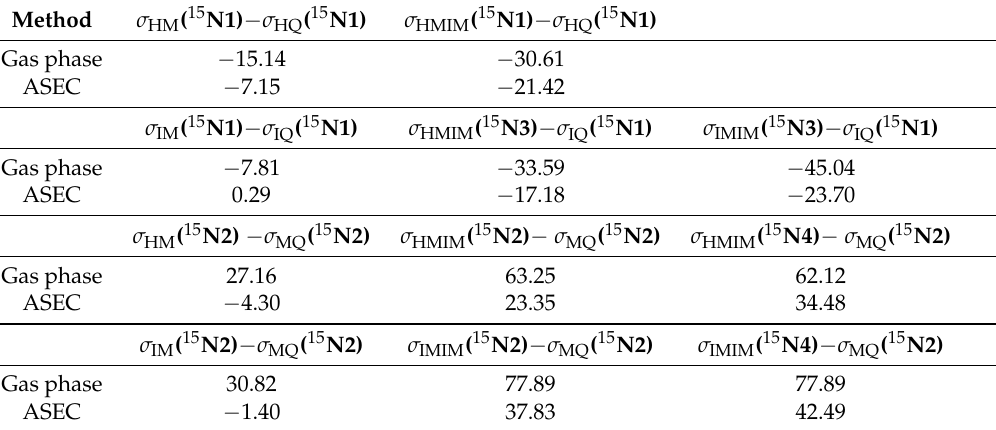
Table 4. ASEC results for 15 N shielding magnetic differences (in ppm) of nitrogens in dimers (HM,IM) and in tetramers (HMIM,IMIM) relative to nitrogens in monomers